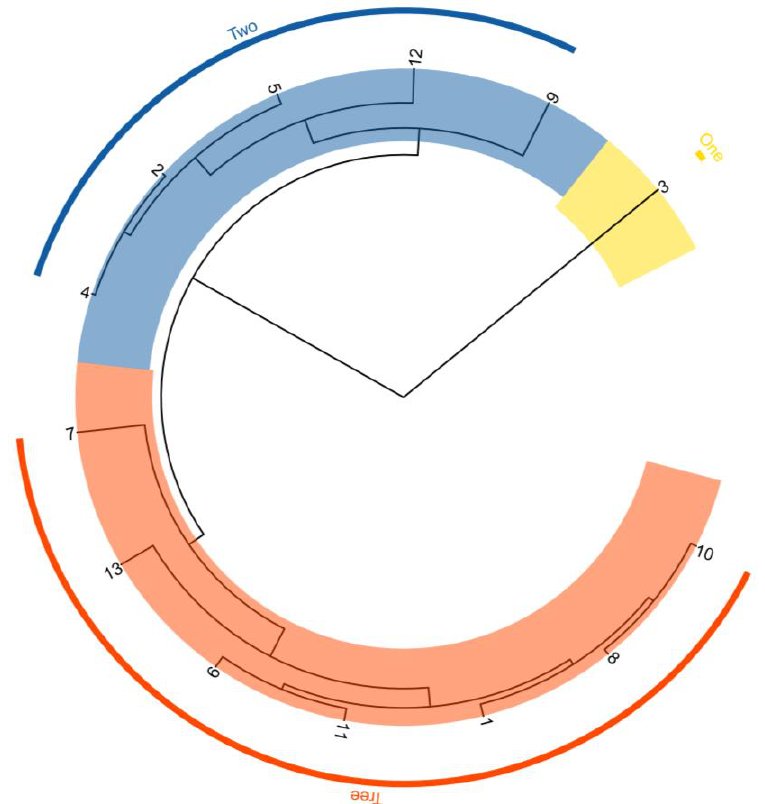
Figure 3. Cluster analysis chart of content traits of different germplasm of Radix bupleuri .